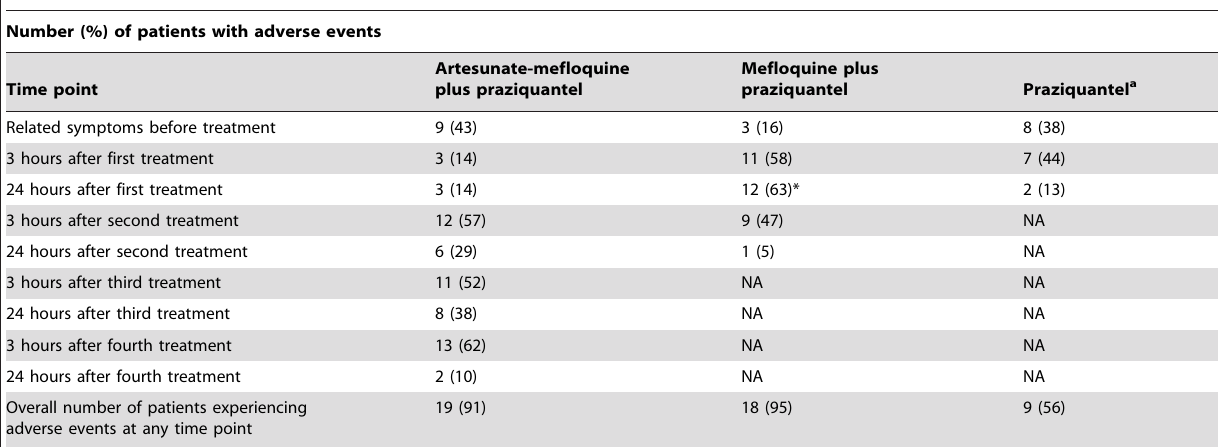
Table 4. Number of children with adverse events among the three treatment arms, as assessed at different time points